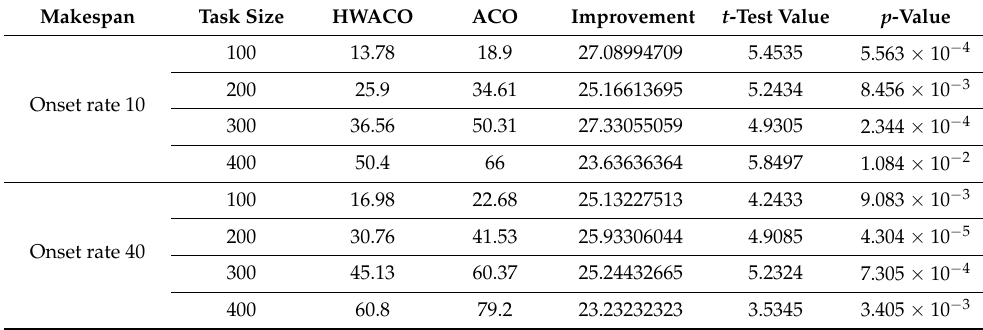
Table 6. t -Test for makespan between HWACO and ACO.